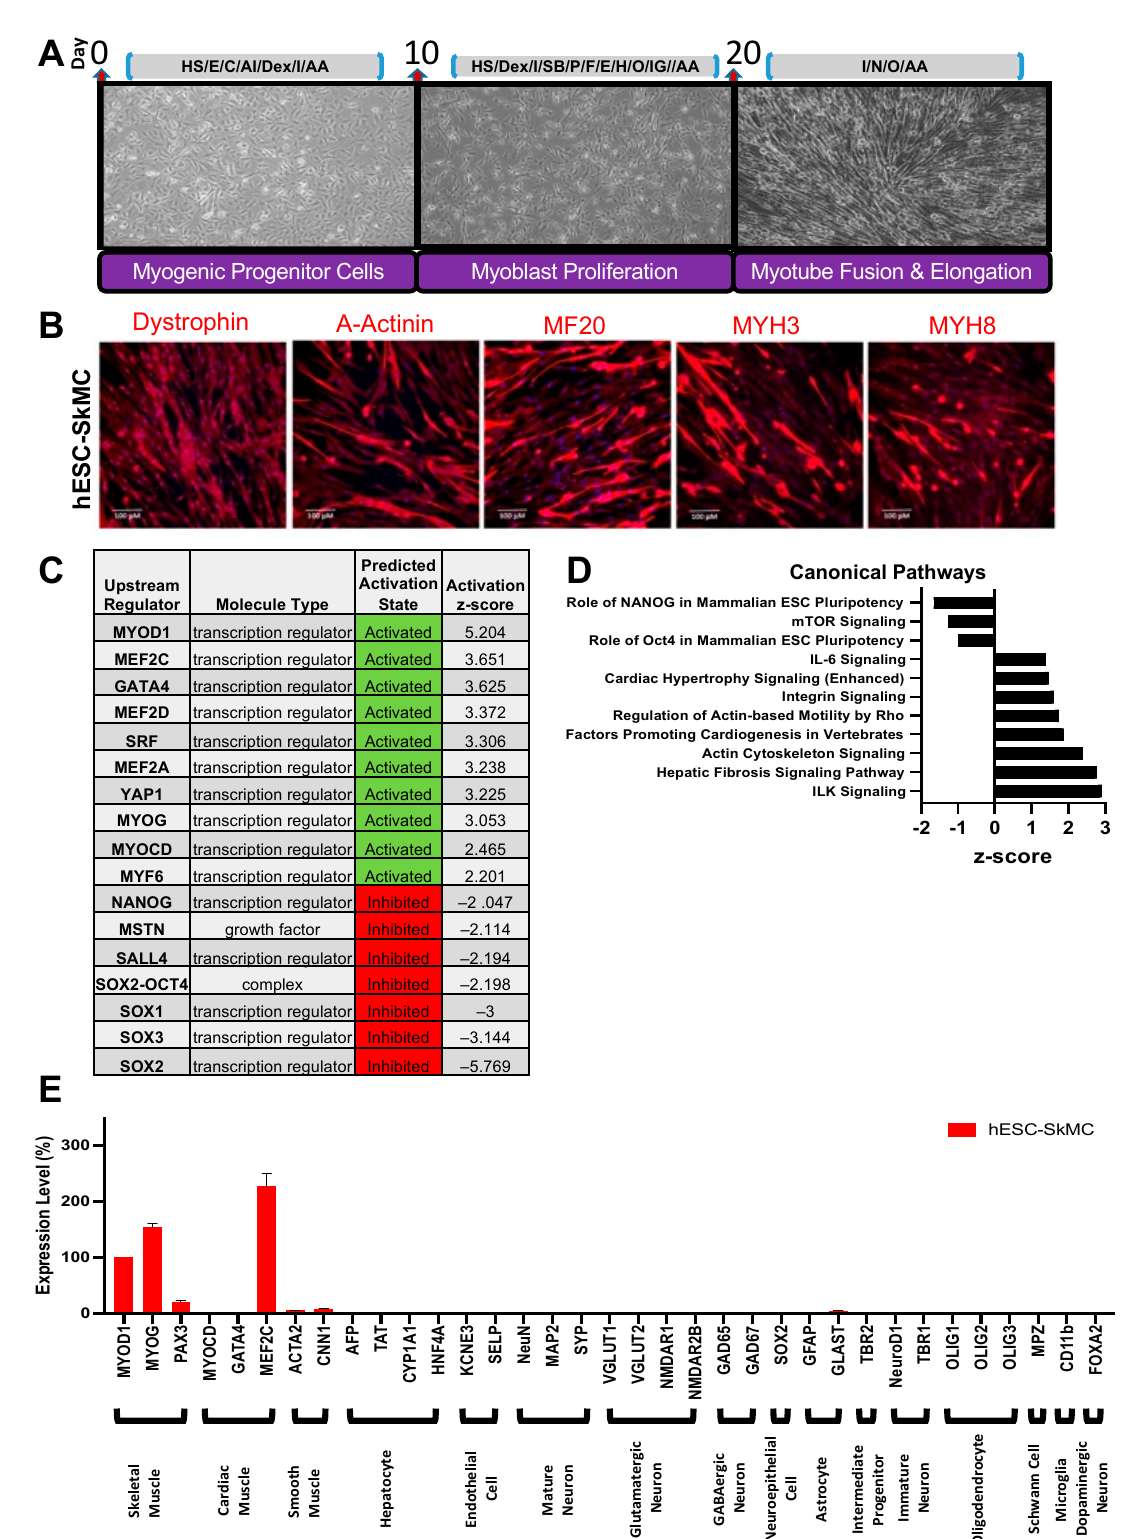
Figure 1. Skeletal muscle differentiation of hESCs. ( A ) Differentiation protocol for the derivation of SkMCs from hESCs. HS = horse serum, E = hr-EGF, C = CHIR99021, AI = ALK5 inhibitor, Dex = dexamethasone, AA = ascorbic acid, I = insulin, SB = SB431542, P = hr-PDGF, F = hr-FGFB, H = hr-HGF, O = oncostatin, IG = hr-IGF1, N = necrosulfonamide. ( B ) hESC-SkMCs expressed